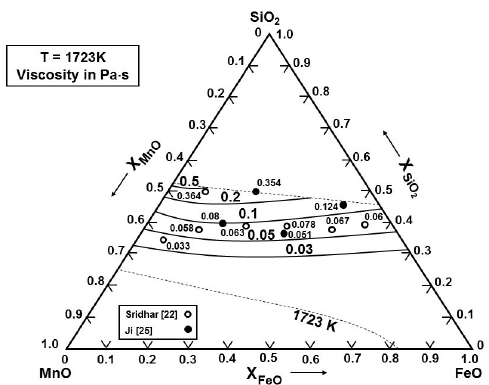
Figure 9. Isoviscosity curves (Pa ⋅ s) of SiO 1673 K.